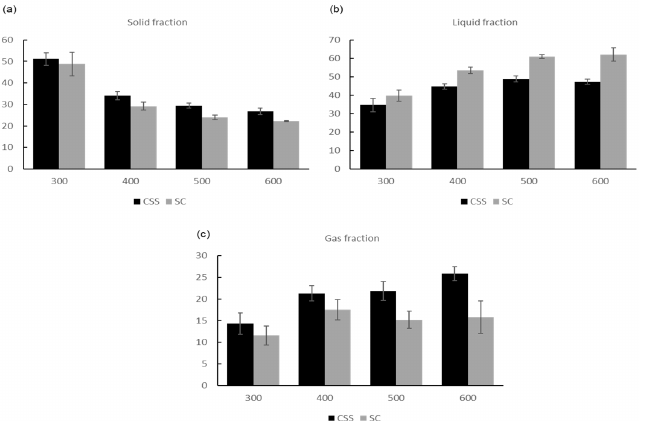
Figure 7. Comparison of solid, liquid, and gas fractions (wt.%) in the pyrolysis of CSS and SC at different temperatures (°C): ( a ) solid fraction; ( b ) liquid fraction; and ( c ) gas fraction. Similar results were obtained in the case of the slow pyrolysis of sawdust. The same temperatures were tested (300, 400, 500, and 600 °C) as recommended by other authors [40–42]. Solid fraction yields descended from 51.0 to 21.7% as the temperature increased, while liquid and gas fractions increased. Liquid yields were in the range of 38.3 to 57.8%, whereas gas fraction yields varied from 10.7 to 21.8% [17,18]. The yields shown in Figure 7 are in the same order as the slow pyrolysis of sawdust since CSS, SC, and sawdust are all lignocellulosic residues with cellulose, hemicellulose, and lignin contents. According to the results in Tables 1 and 2, the higher ash content in CSS could justify the higher content of biochar (solid fraction obtained after pyrolysis) in the CSS compared to the SC.